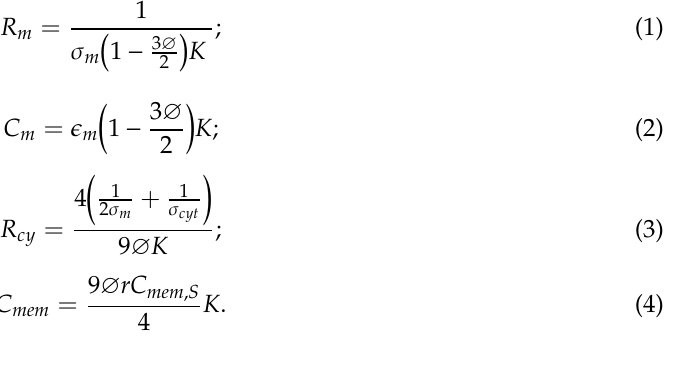
Table 2. Intrinsic parameters of the electrical